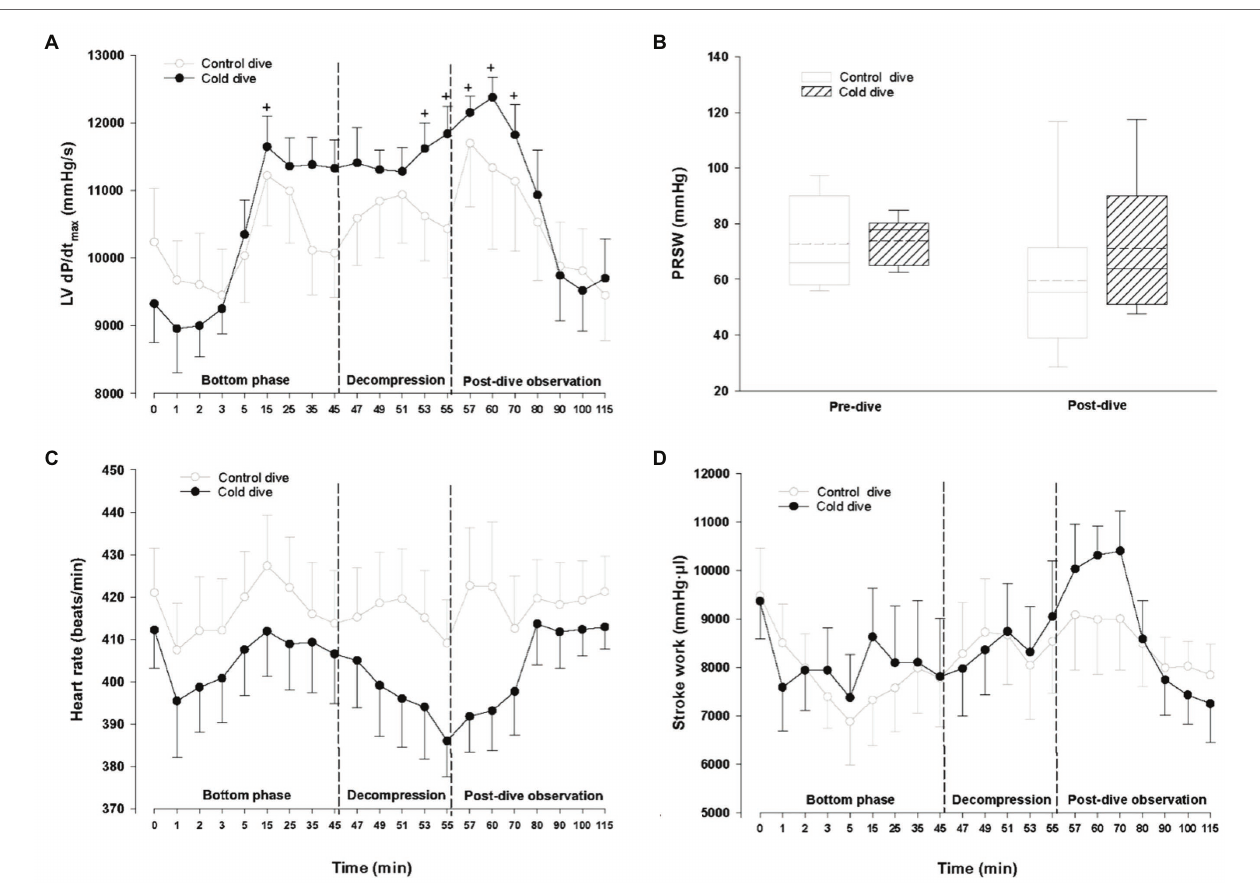
FIGURE 4 | Hemodynamic variables (cont.). (A) Maximal slope of systolic pressure increment (LV dP/dt max ), (B) preload recruitable stroke work (PRSW), (C) heart rate (HR), and (D) Stroke work (SW). Data presented as mean ± SEM for (A,C) , and (D) . Data are presented as vertical boxes with median (solid line), mean (dashed line) and interquartile range with 10 th and 90 th percentile error bars for (B) . N = 9 in both groups. + p < 0.05 compared to baseline in the cold dive group. # p < 0.05. Data for the control dive group are adapted from Gaustad et al. (2020).